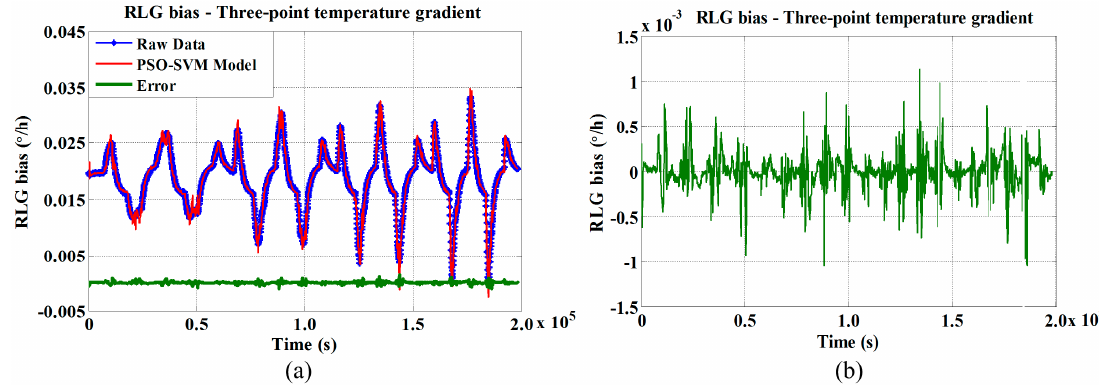
11 Figure 5. ( a ) Correlation analysis between the RLG bias and multiple-point temperature gradient algorithm; ( b ) Enlarged figure obtained from ( a ). 4.3. RLG Bias Compensation Results Utilizing Multiple-Point Temperature Gradient PSO Tuning of SVM Algorithm According to Figure 5, we find that the most of the correlation coefficients for temperature gradients related to thermometer A, which is placed near the cathode, are higher than 0.90. Among the other correlation coefficients of temperature gradients with RLG bias, at least two correlation coefficients are greater than 0.90, which means the multiple-point temperature gradients all contribute to the RLG bias variation. To achieve the highest compensation accuracy, the temperature gradients